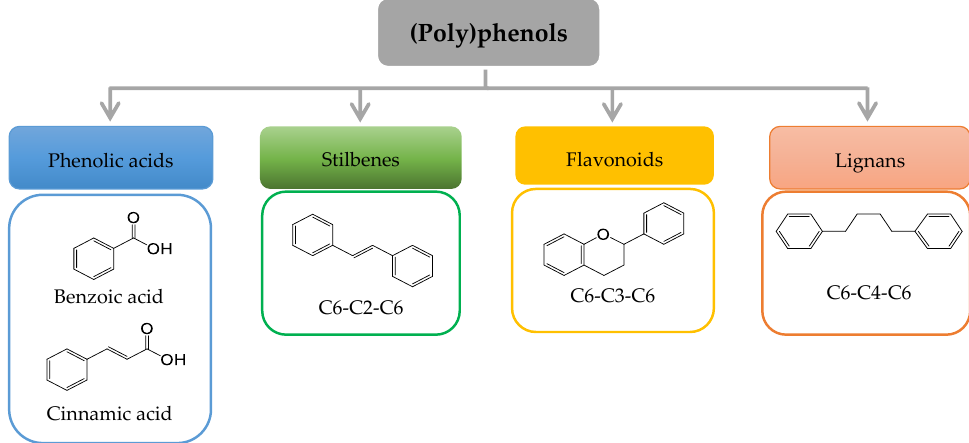
Figure 2. Basic structure of the major groups of (poly)phenols according to the number of phenol rings and the structural elements that bind theses rings.